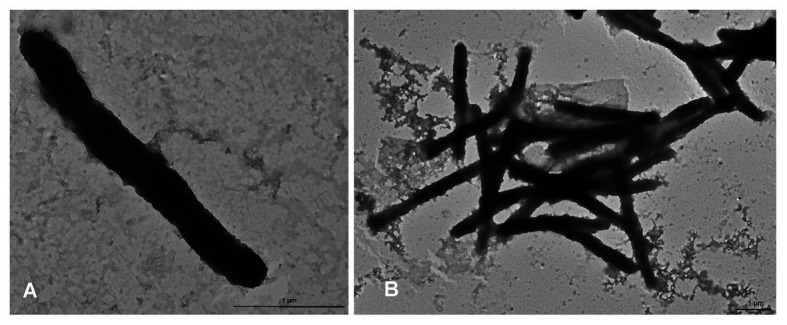
Transmission electron micrographs of Aquimarina sp. TRL1 from 1 d old marine broth cultures showing (A) an individual rod-shaped cell and (B) a mesh of cells.